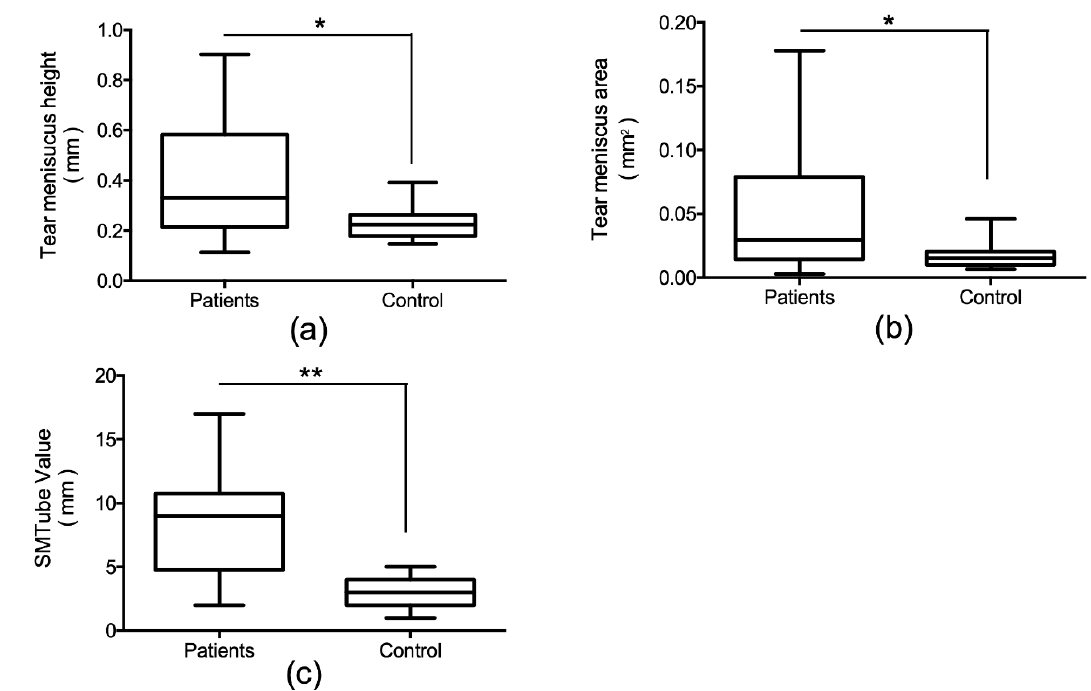
Figure 2. Comparison of tear meniscus parameters measured by optical coherence tomography and SMTube value between the lacrimal passage obstruction patients and control subjects. Tear meniscus height ( a ) and area ( b ) in patients with lacrimal passage obstruction was significantly greater than that in the control subjects. SMTube value in the patients with lacrimal passage obstruction was also significantly greater than that in the control subjects ( c ). * p < 0.05. ** p < 0.001.